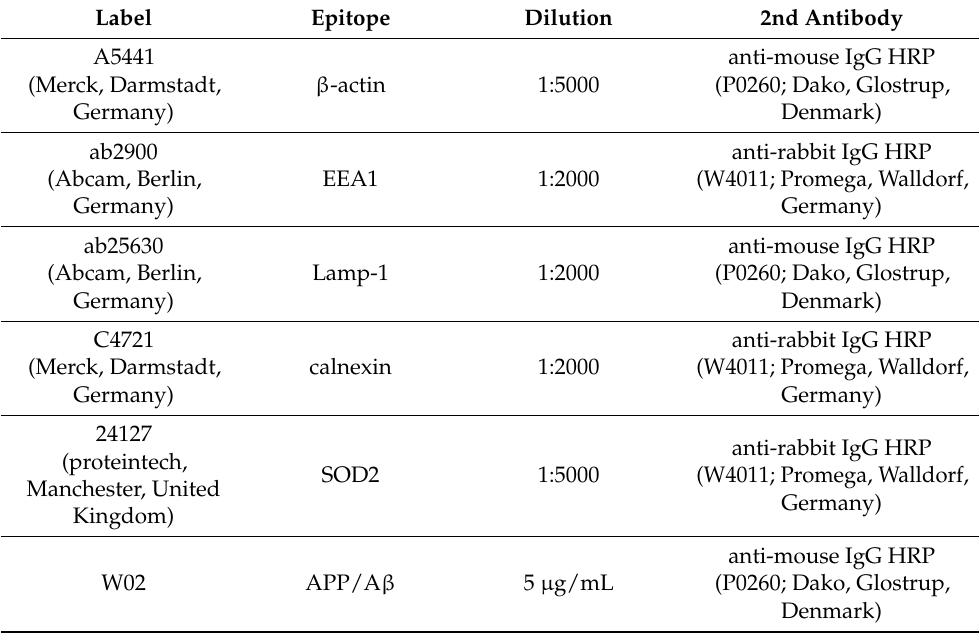
Table 1. Antibodies used in Western blot